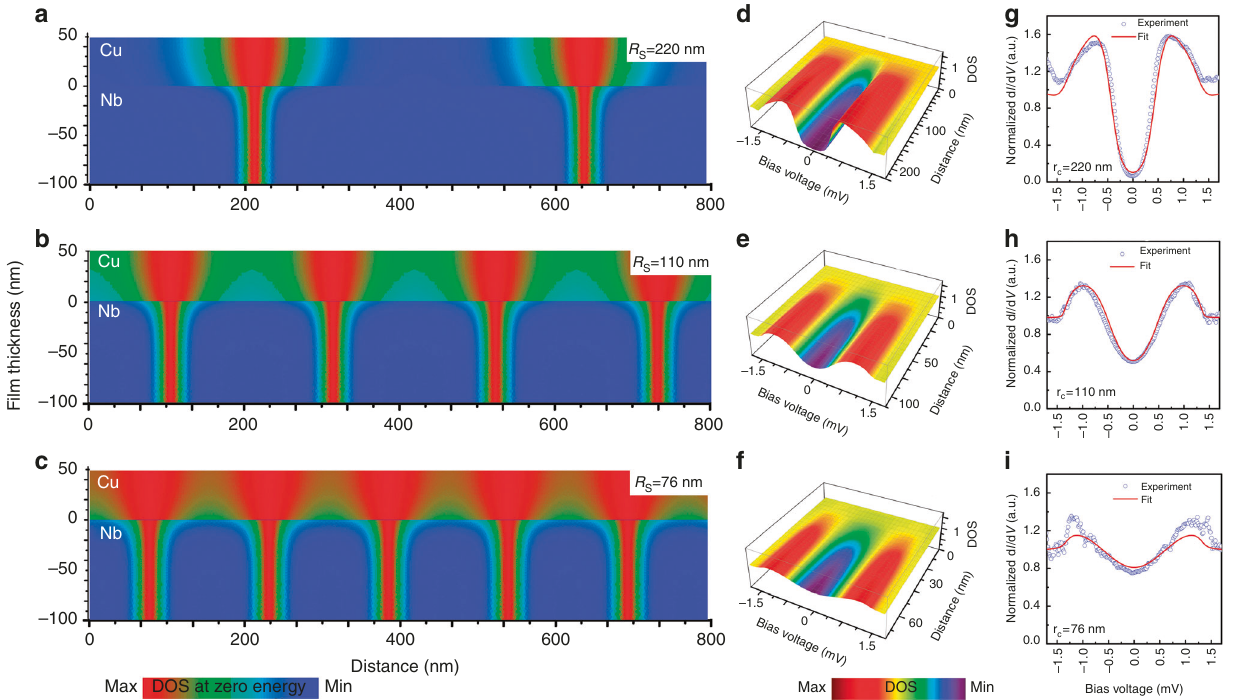
Fig. 3 Calculated local DOS inside Cu/Nb-bilayer. a – c Color-coded zero-bias DOS ( r , z ) maps calculated for three different magnetic fi elds 5, 55, and 120 mT, respectively. d – f Calculated 3D-plot of the radial evolution of the tunneling DOS in the vicinity of the proximity vortex cores; the magnetic fi elds are the same as in a , c . g – i Dots: experimental tunneling spectra acquired away from the vortex cores at three magnetic fi elds as in a – c — lines: DOS fi ts calculated at the edge R S ( H ) of the circular vortex lattice unit cell (see in the